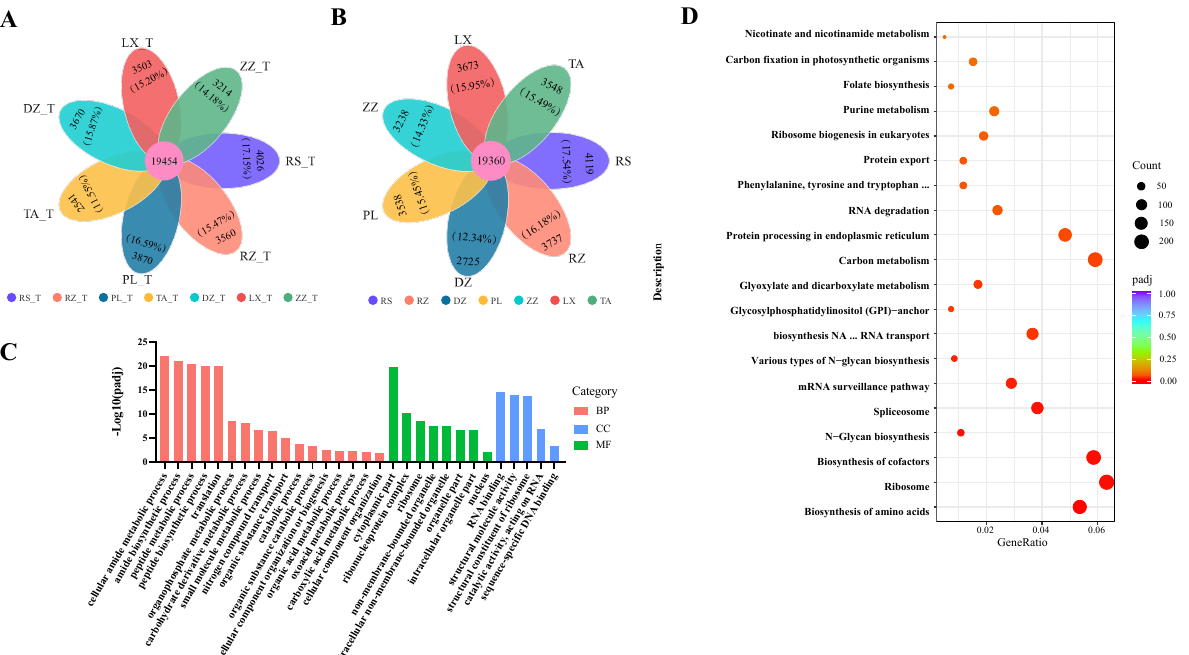
Figure 3. Petal mapping and KEGG pathway analysis for the overlapping and unique genes related to the localized samples in seven regions. ( A , B ) Petal map shows the overlapping and unique genes from regions at half-v é raison ( A ) and maturity ( B ), in this figure ‘T’ means half-v é raison stage. The percentage was the ratio of unique genes to the total genes in the region. ( C ) Category of biological functions related to DEGs according to the comparative combinations of different regions at maturity. ( D ) The distribution of sample data by stacking dots along the horizontal axis to represent the frequencies of different values. Abscises represent the GeneRatio, and the ordinate represents in terms of KEGG pathway. The GeneRatio refers to the ratio of the sample number to the background enriched in the pathway. Padj indicated that those closer to zero express greater